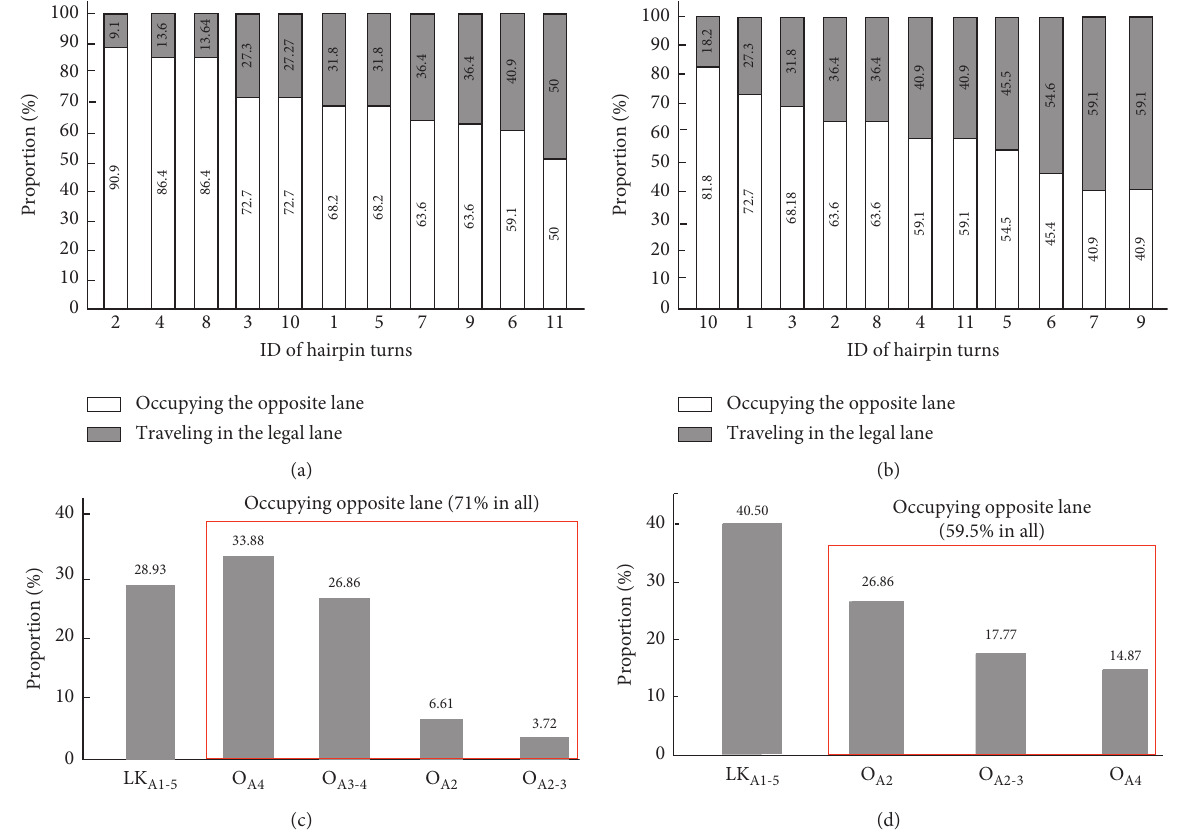
Figure 12: Opposite lane-occupying behaviors and their proportions. (a) Left-hand turns. (b) Right-hand turns. (c) Left-hand turns. (d) Right-hand